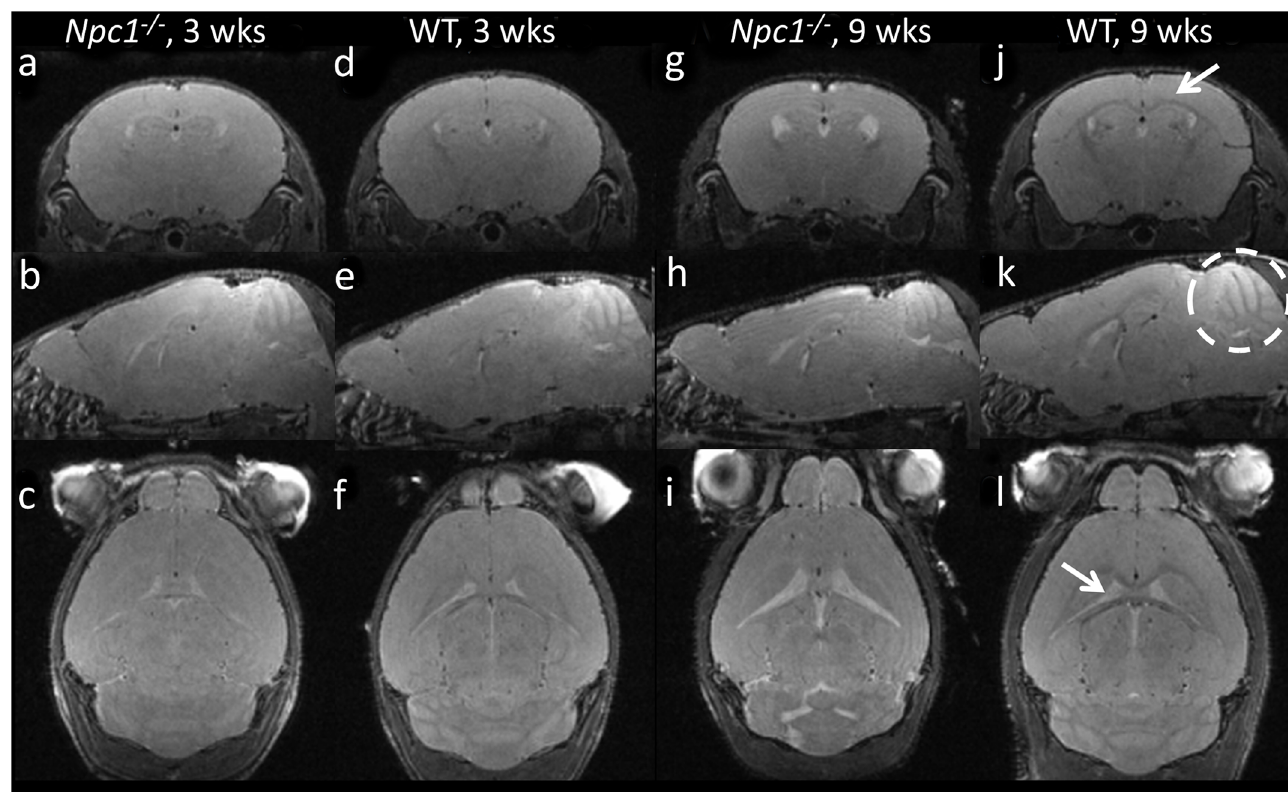
Fig 1. Example anatomical MRI images of mice at early and late timepoints. Examplehigh resolution T2-weighted in vivo images of Npc1 -/- (a-c, g-i) and WT (d-f, j-l) mice at 3 weeks (a-f) and 9 weeks (g-l) of age. At three weeks of age there are only slight differences betweenin the brains of Npc1 -/- and WT mice, but can be seen in the white matter regions of the brain. These differences become more pronounced at 9 weeks of age. The arrow in panel j points to the regionof the corpus callosumand external capsulein a WT mouse, which demonstrates a dark band of intensity comparedto the surroundinggray matter. This is reversed in the Npc1 -/- mouse. The cerebellumis circled in panel k , which is visibly reducedin size in the Npc1 -/- mouse at 9 weeks. The arrow in panel l indicatesthe bright signal of the CSF in the lateral ventricles, which are increasedin size in the Npc1 -/- mouse at 9